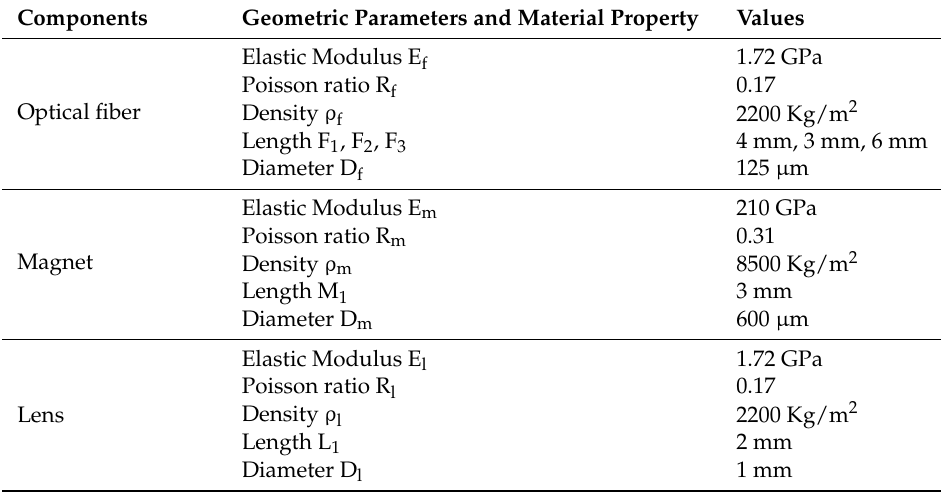
Table 1. Geometric parameters and material properties for the fiber scanner model.